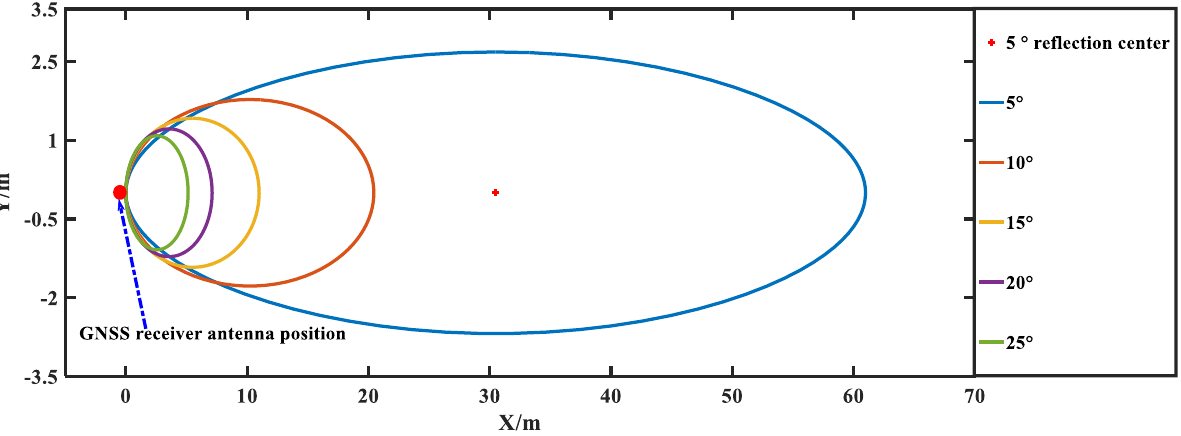
Figure 10. First Fresnel reflection region for GPS L 2 frequency at different elevation angles.